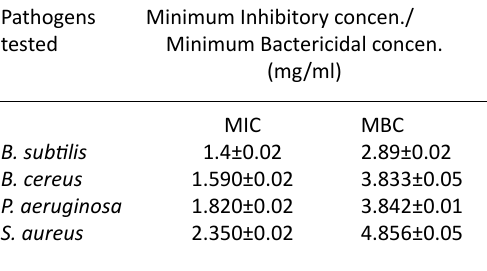
Table 4. MIC and MBC Pathogens Minimum Inhibitory concen./